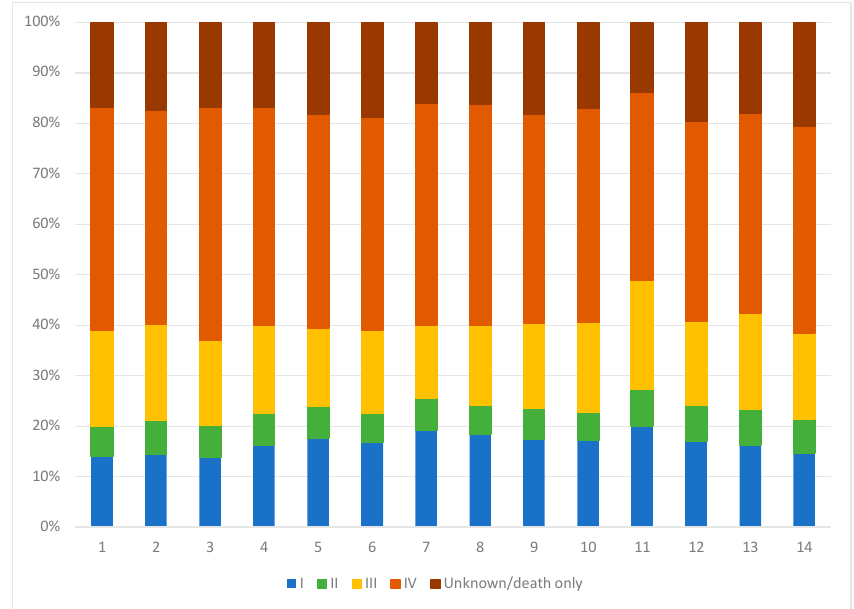
Figure 3. Stage of disease at lung cancer diagnosis, by LHIN. This graph demonstrates the stage of LC at diagnosis for patients in each LHIN throughout the study period. There are differences between LHINs, with some having higher proportions of early stage (LHIN 5–8, 11) and others having more patients with stage unknown or stage IV (LHIN 3, 12, 14).